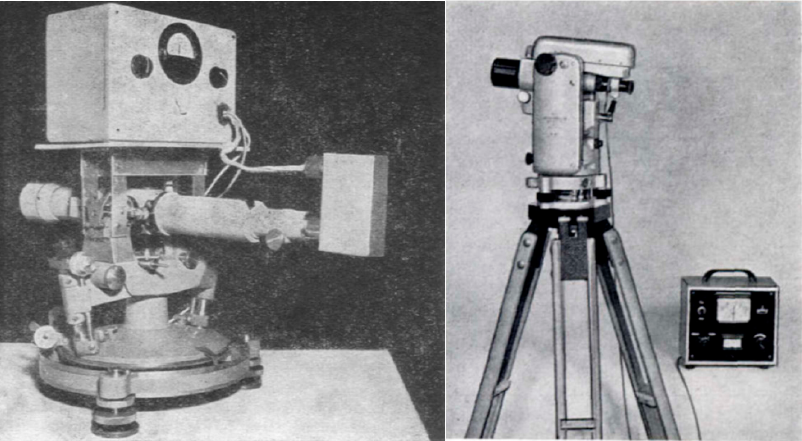
Figure 4. Electronic Eye from the Frankfurt Institute of Applied Geodesy ( left ) and the Askania Tracking System ( right ) [21,22].